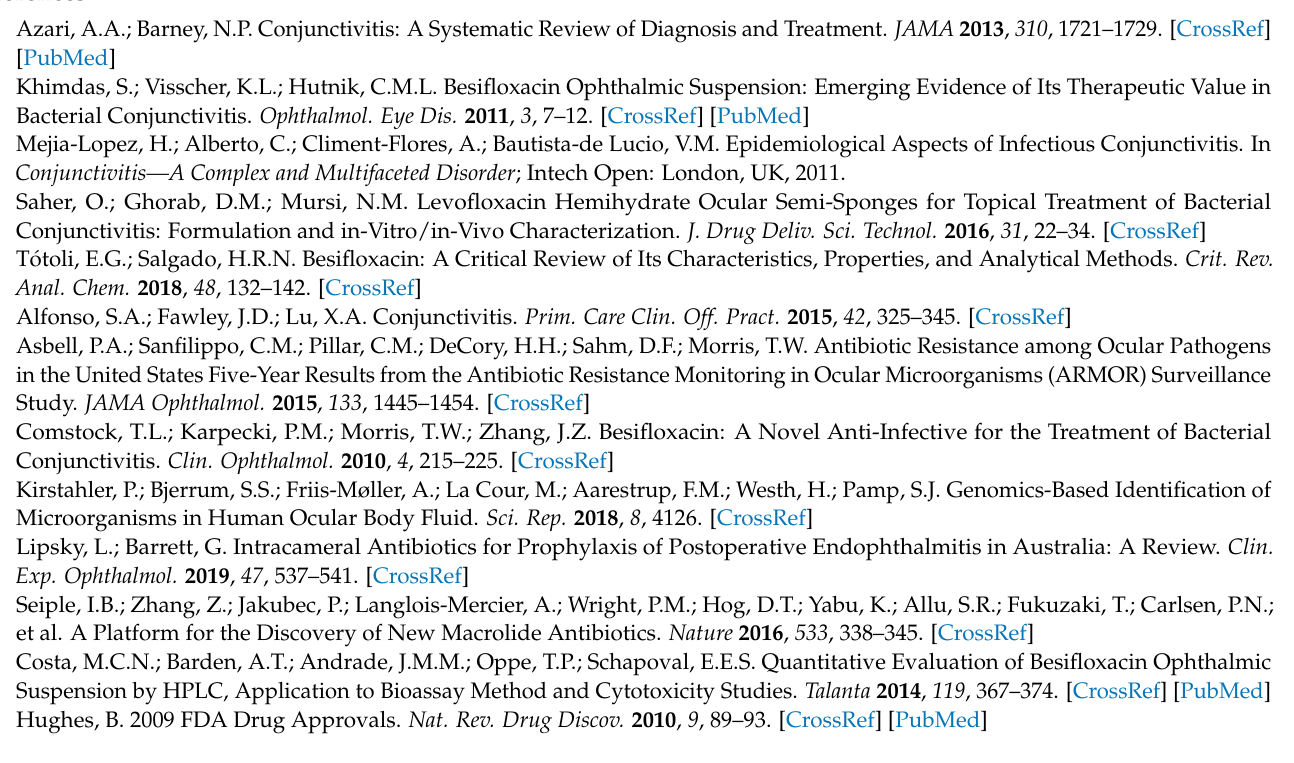
study; Figure S3: Freeze-dried besifloxacin nanosuspension DLS measurements: (a) Size distribution by intensity; (b) Size distribution by volume; (c) Correlogram; (d) Z-average trend; (e) Statistics graph n = 3; Figure S4: X-ray diffraction of besifloxacin (raw material) and nanocrystals (freeze- dried). Figure S5: Toxicity of besifloxacin nanocrystals (500 mg/kg) and Povacoat ® (750